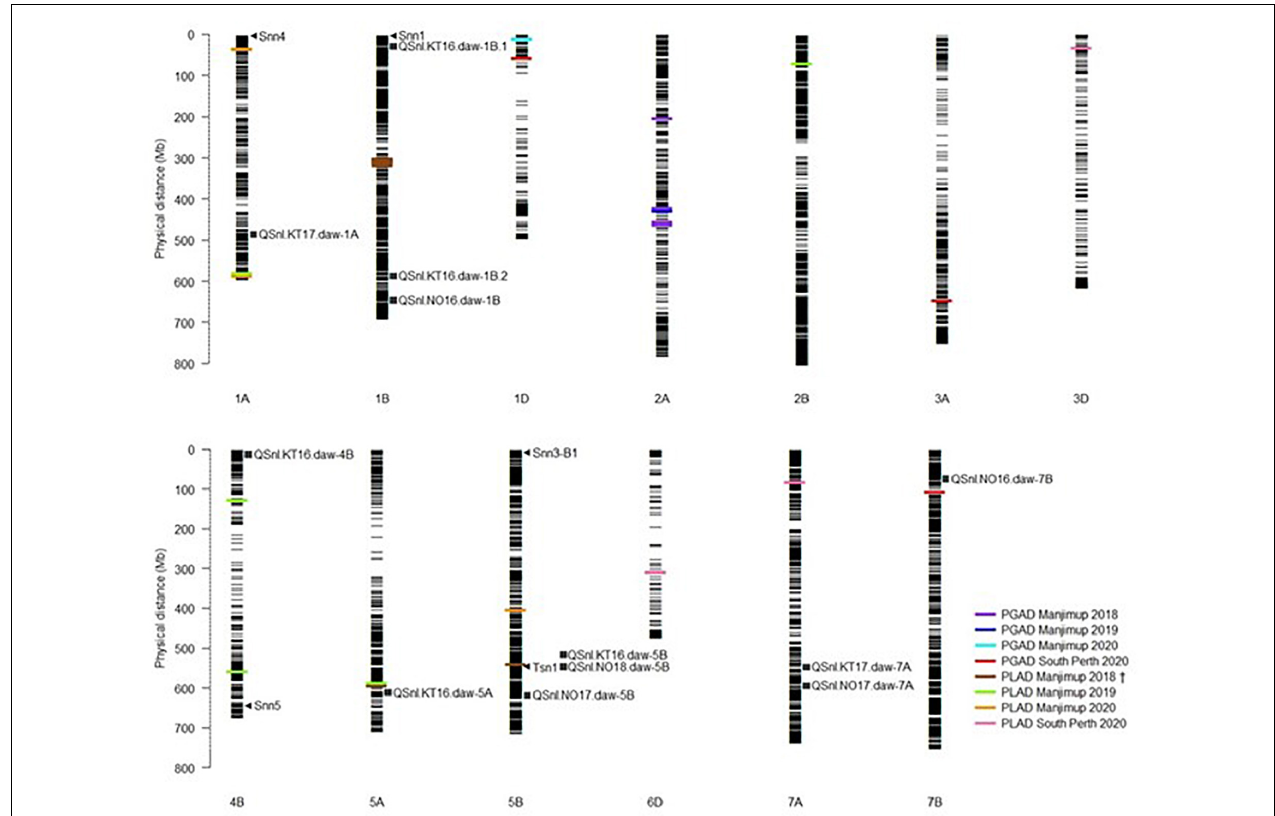
FIGURE 1 | Comparison of QTL for PGAD and PLAD resistance. Assignment of known Tsn and Sn n loci and position of MTA detected in multiple environments in 2018–2020 on the Chinese Spring physical map (IGWSC RefSeq v1.0). Black horizontal lines represent the physical locations (Mb) of SNP markers used in GWAS analysis. Colored bars represent the MTA detected in different environments in 2018–2020. Arrows indicate putative location of known Snn and Tsn1 loci. Squares indicate QTL for foliar SNB resistance detected in 2016–2018 and reported in Francki et al., 2020. † PLAD Manjimup 2018 also reported in Francki et al.